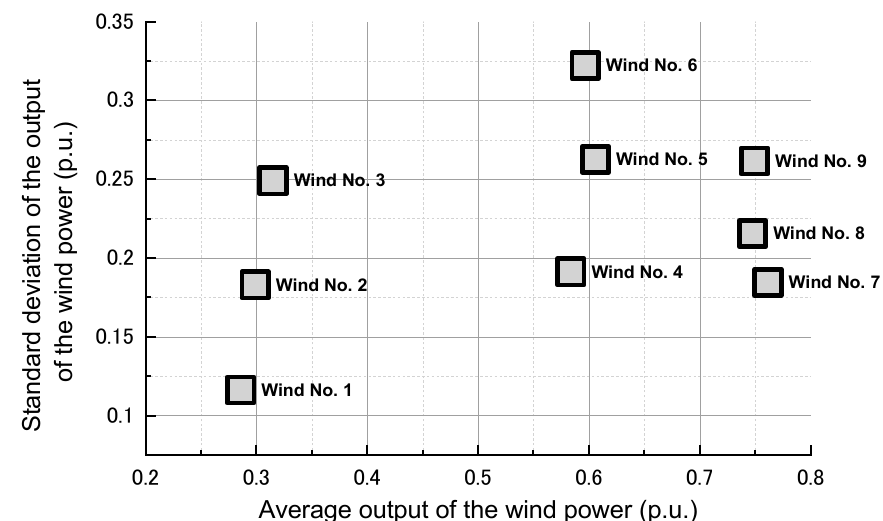
Figure 12. Profiles of the wind power station output. Appl. Sci. 2020 , 10 , 9085